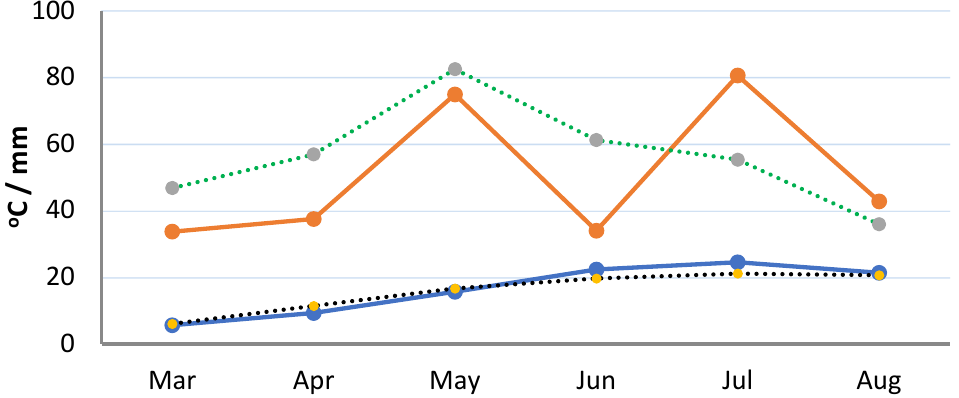
Figure 1. The average monthly temperature (°C, blue line) and monthly precipitation (mm, orange line) during the growing season of onions. The long-term average monthly temperature (black line) and monthly precipitation (green line) are presented as interrupted lines. Table 1. Agrochemical analysis of the research area soil.